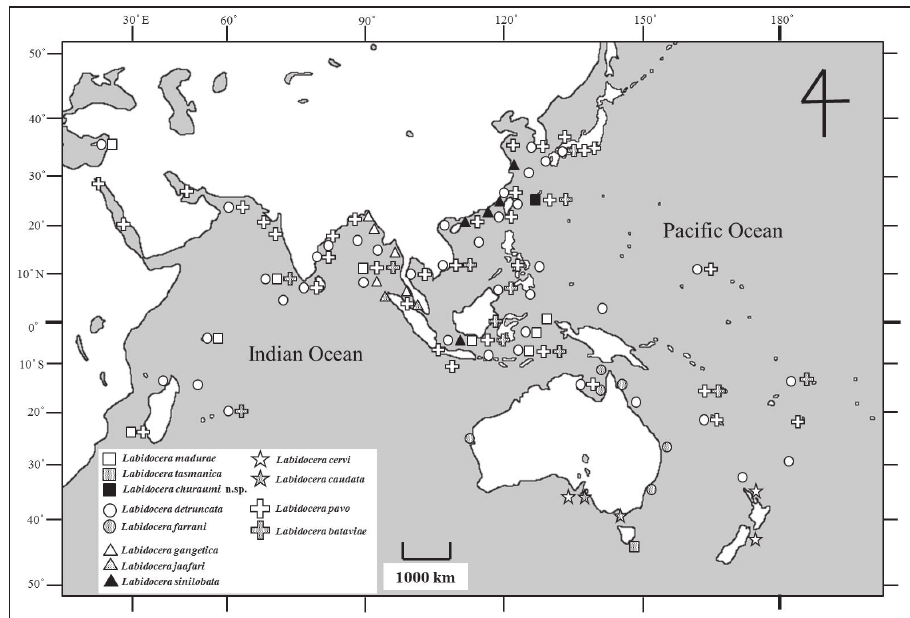
Figure 5. Distribution of Labidocera detruncata species complex based on previous records and present